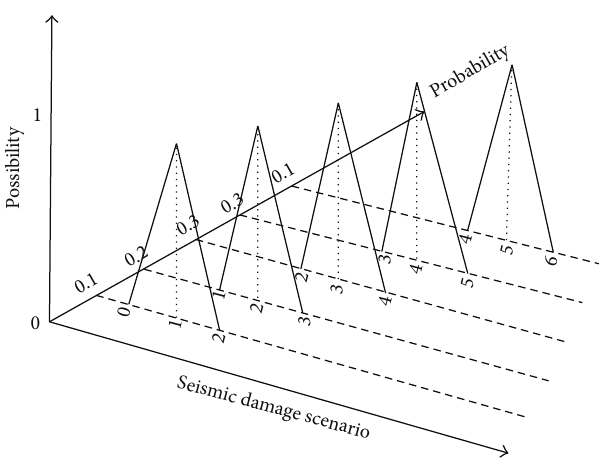
Figure 3: Value of seismic damage